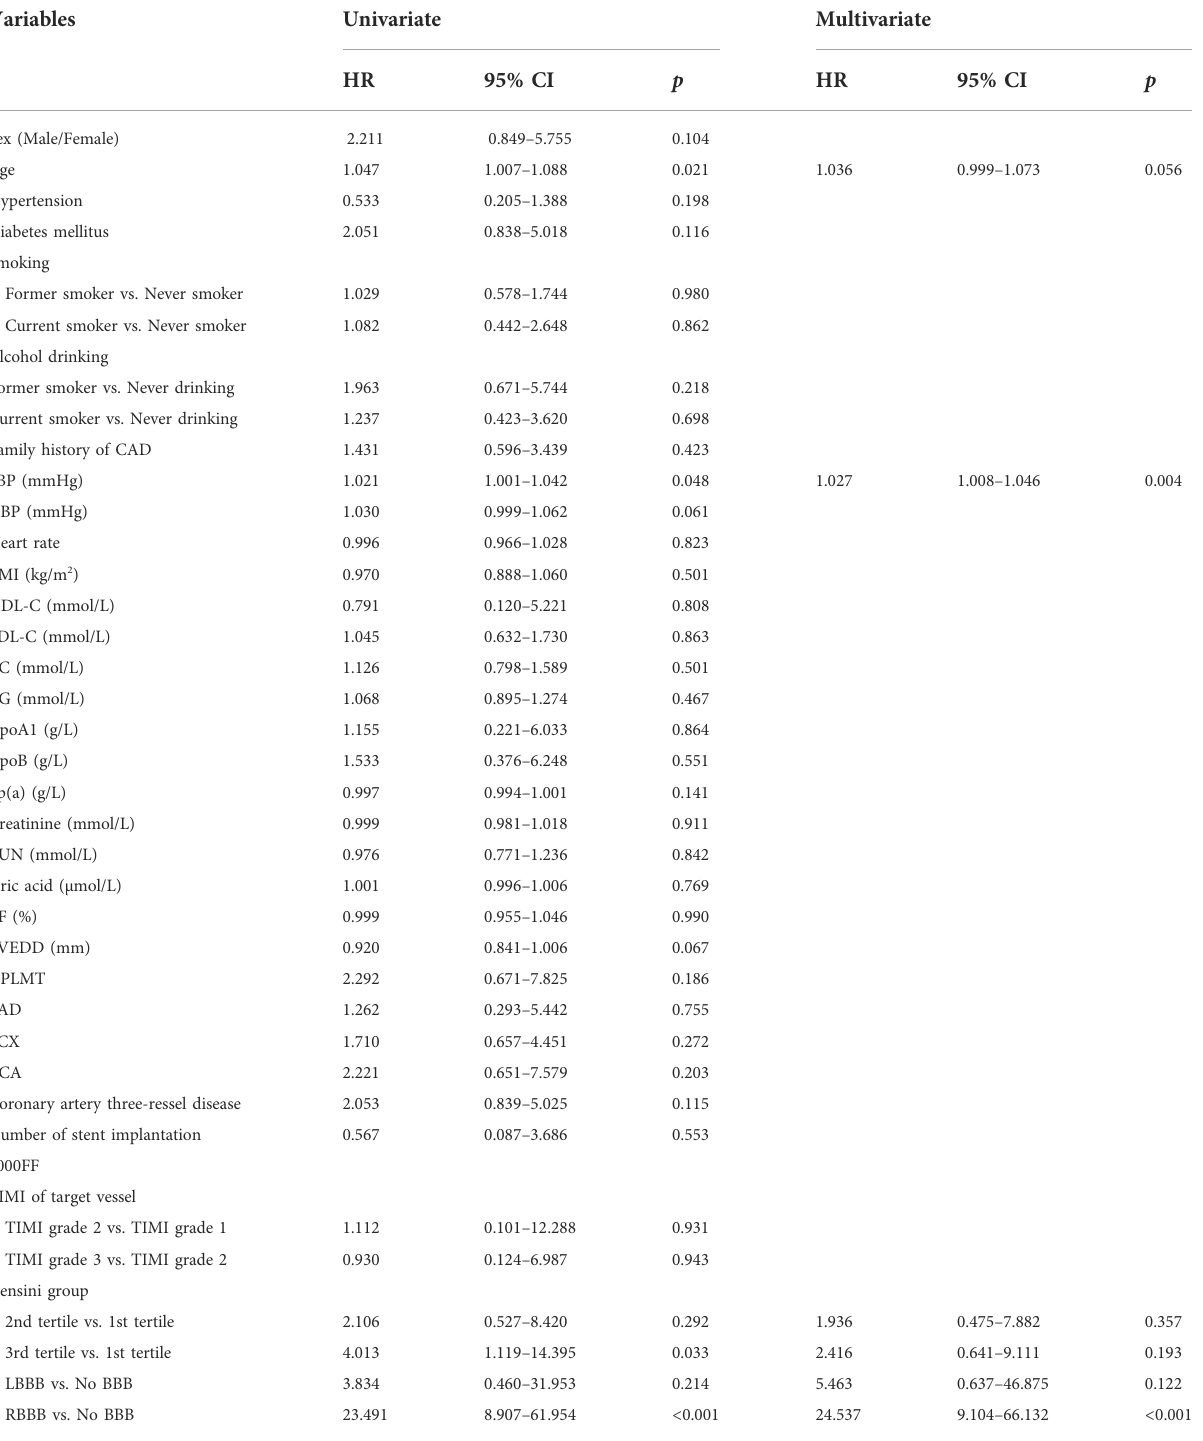
TABLE 6 Potential predictors for the incidence of all-cause mortality in patients with new onset STEMI who underwent PCI.